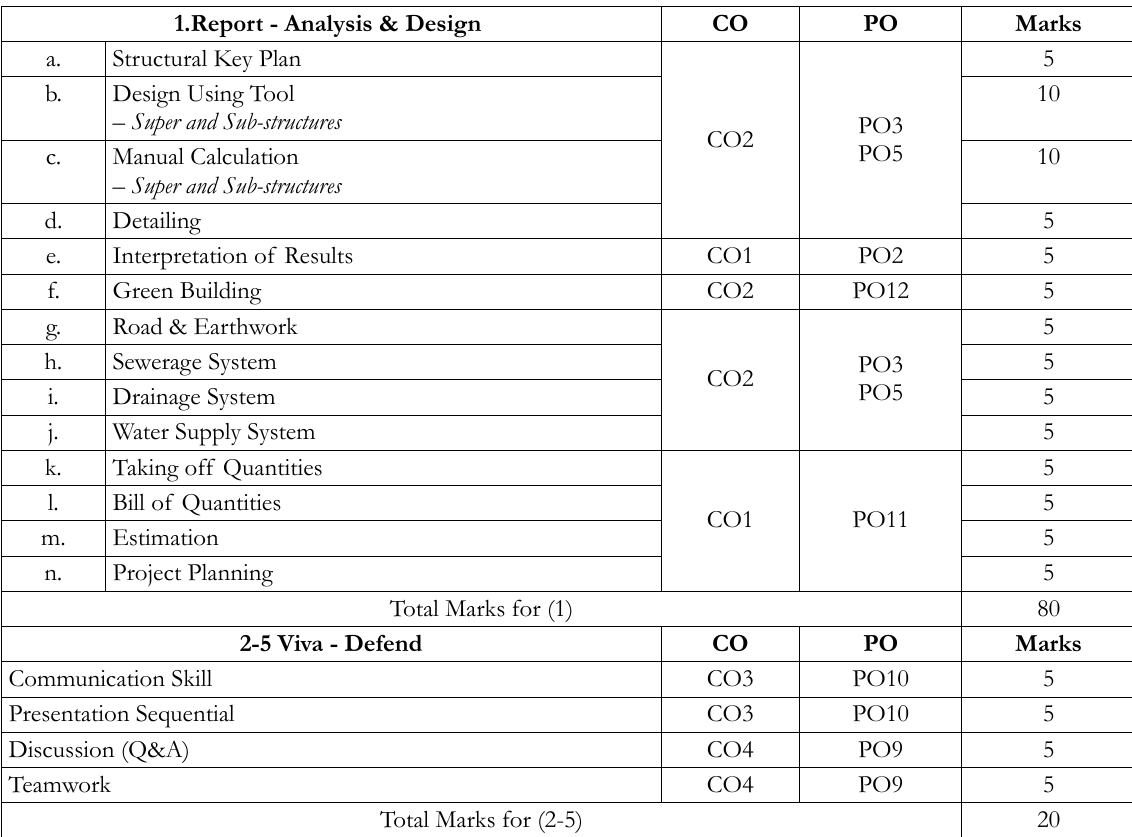
Table 4. Assessment form of